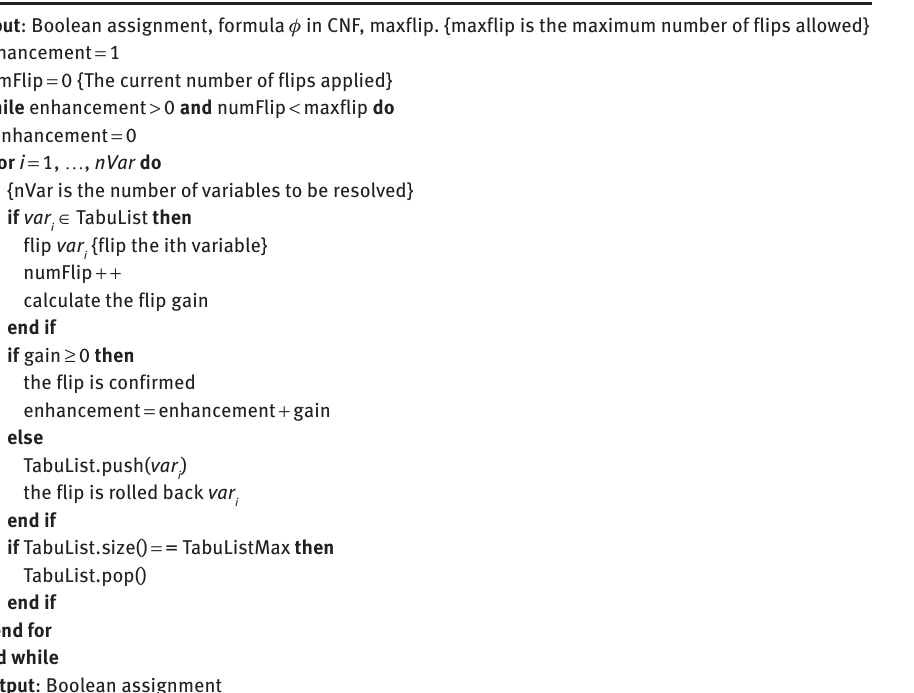
Algorithm 3: Local Search Procedure based on Tabu Search and Flip Heuristic